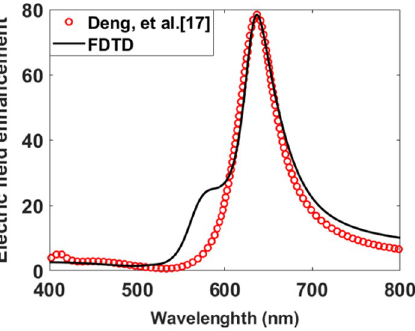
Figure 3. Variation of the wavelength-dependent intensity enhancement of plasmonic nanoantenna-dielectric nanocavity 17 and by using the FDTD